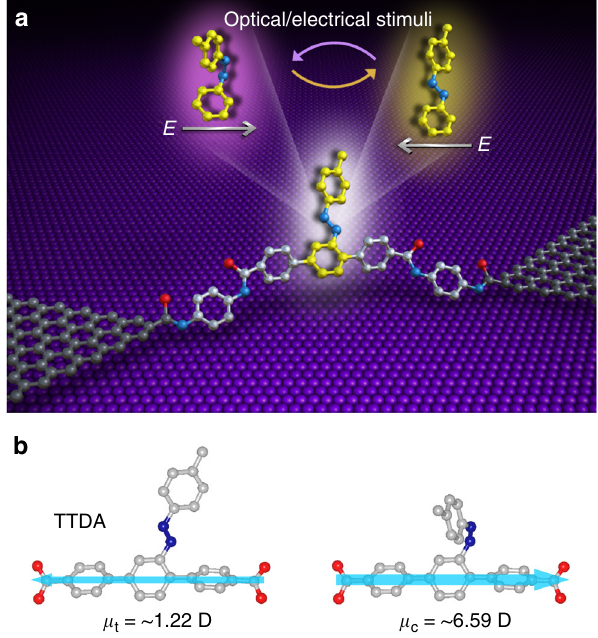
Fig. 1 Device structure and dipole analysis of TTDA. a Schematic representation of the device structure that highlights a reversible isomerisation of the azobenzene unit between trans and cis forms triggered by either optical or electrical stimuli. The azobenzene sidegroup serves as a chemical gate to modulate the conductance of the molecular backbone. b Dipole projection on the molecular backbone (the actual charge transport pathway). The arrow denotes the direction of the dipole